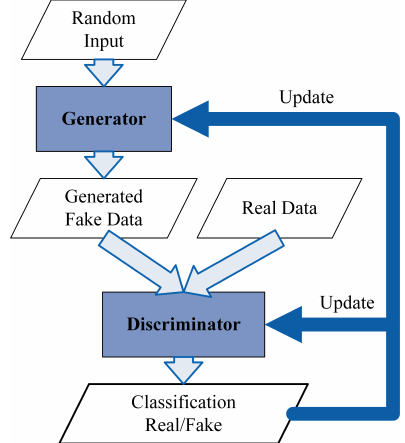
Figure 1. Generative Adversarial